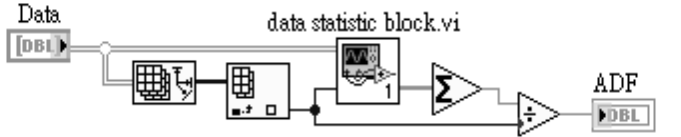
based pH sensor 2